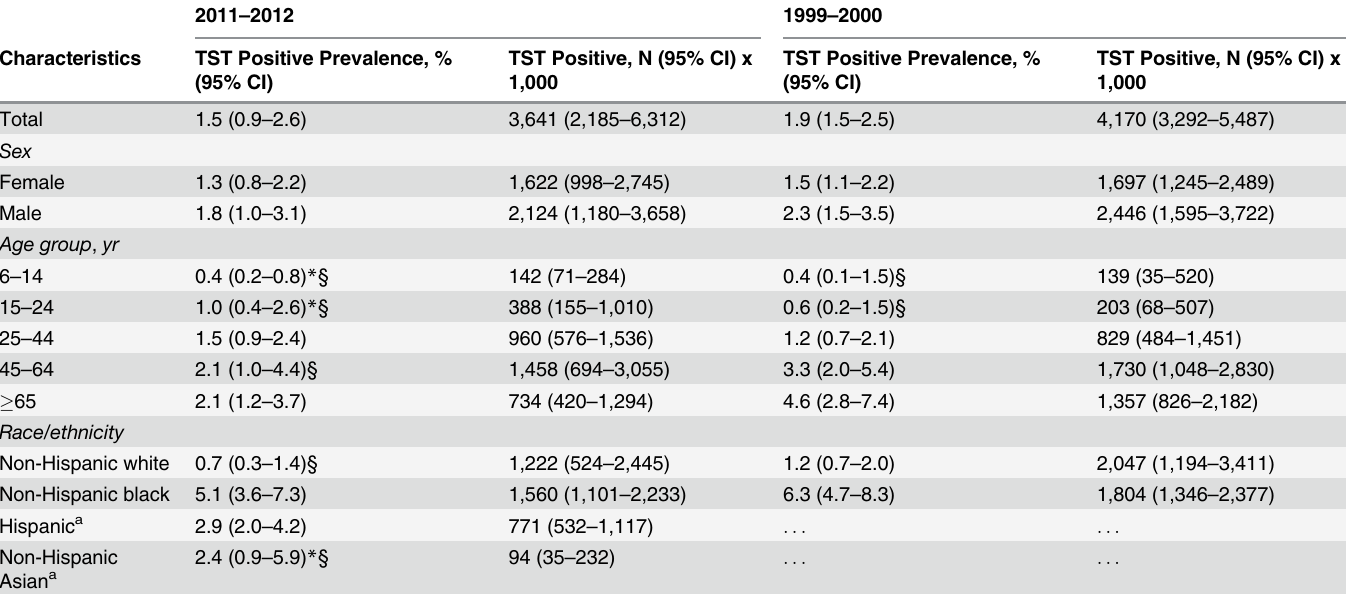
Table 2. Tuberculin Skin Test Positive Prevalence in the Civilian, Noninstitutionalized U.S.-born Population, Ages 6+, United States, 2011 – 2012 and 1999 –